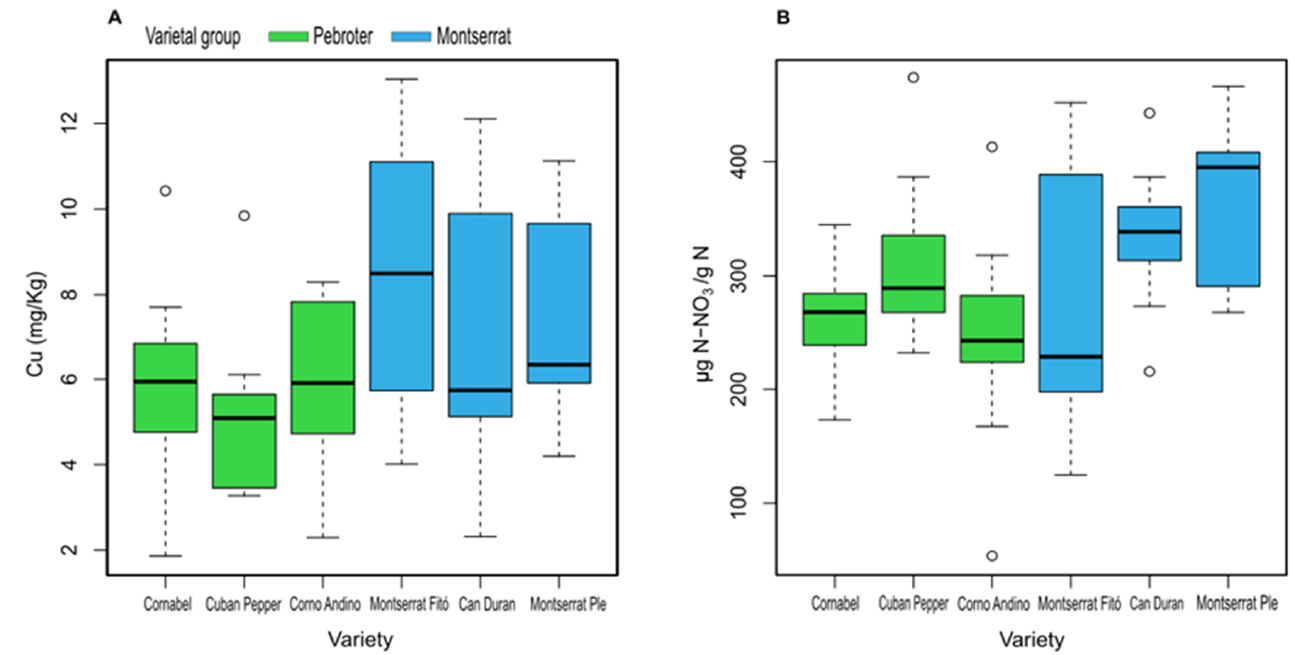
Figure 2. Concentrations of Cu ( A ) and N-NO 3 ( B ) in leaves of tomato varieties.